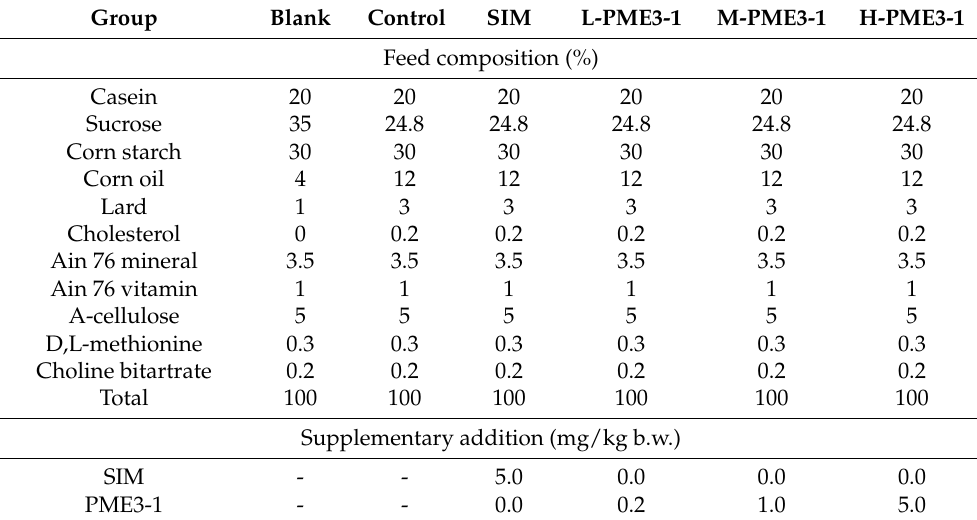
Table 1. The animal feed formula for testing the effect of hypolipidemic and antioxidant of PME3-1 in male